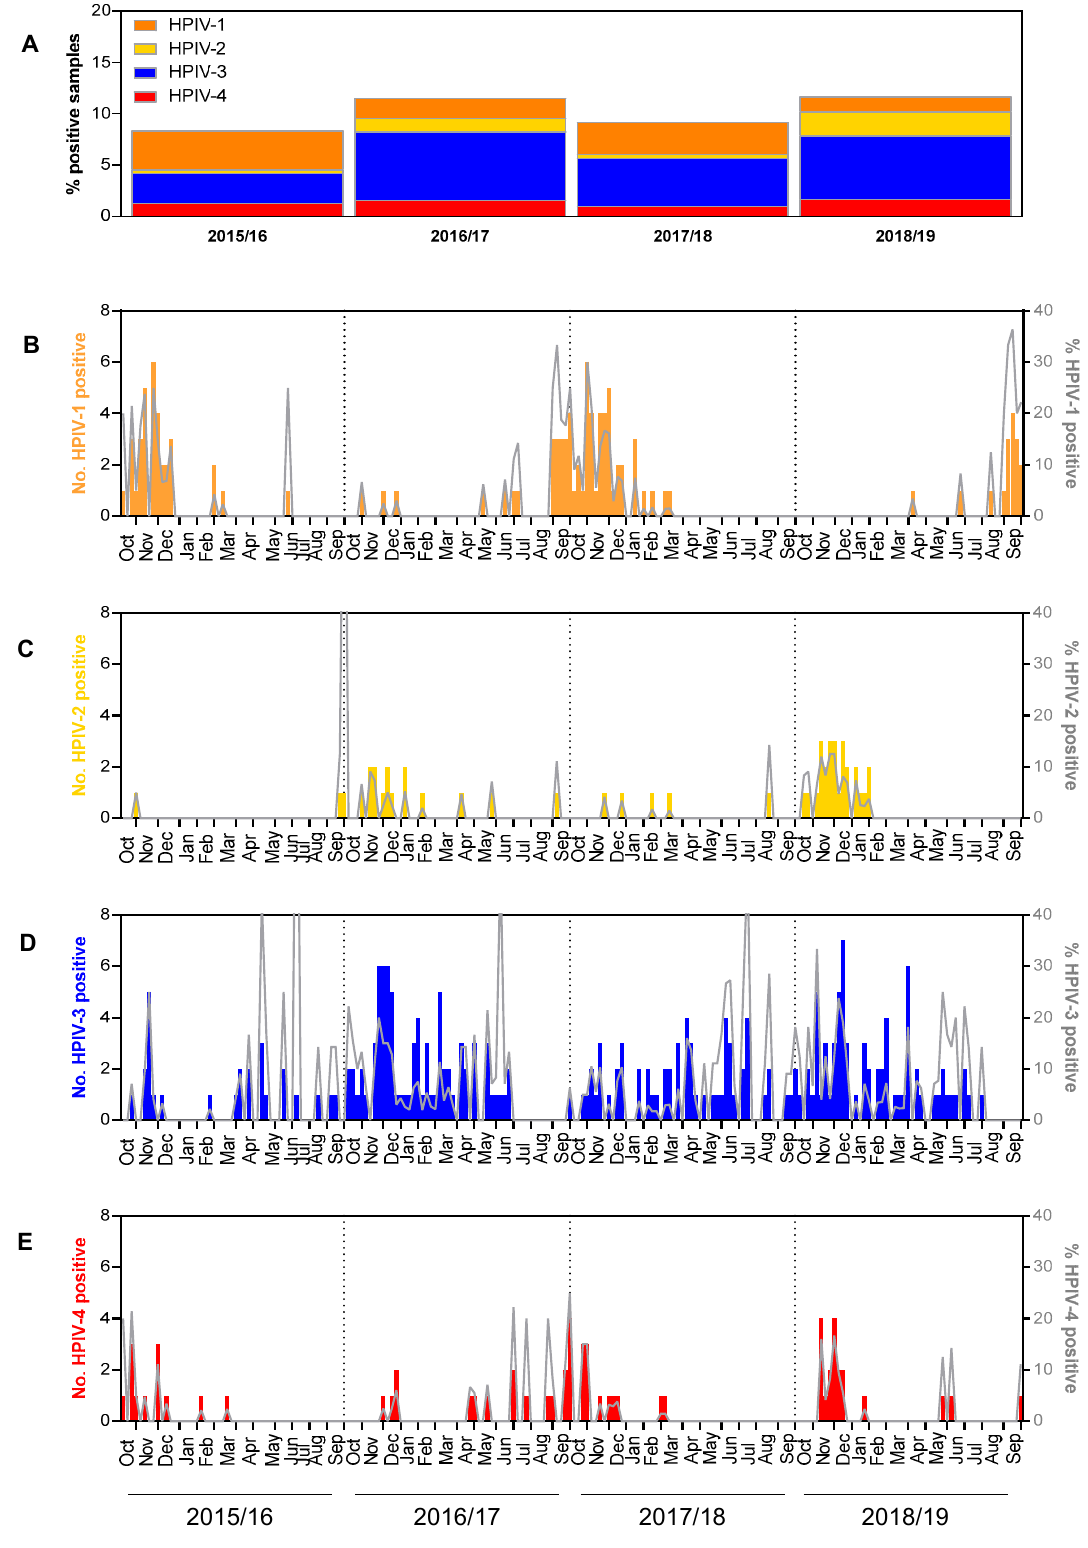
Figure 2. ( A ) Percentage of HPIV-positive samples per season and distribution of HPIV types among them, 2015/16– 2018/19. ( B – E ) Weekly numbers and percentages of samples positive for HPIV types 1–4. Bar plots indicate the number of positive samples and are scaled by the left y -axis, whereas each line represents the percentage of positive samples and is scaled by the right y -axis.